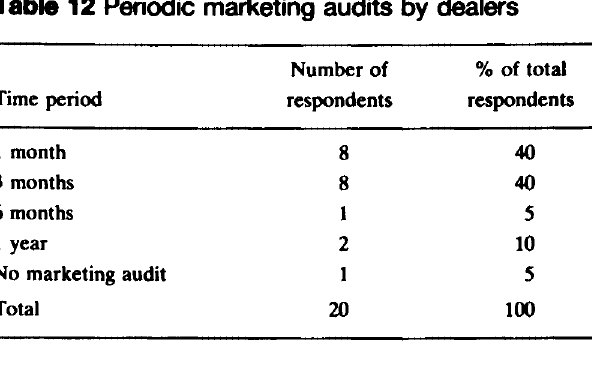
Table 10 Methods employed for positioning